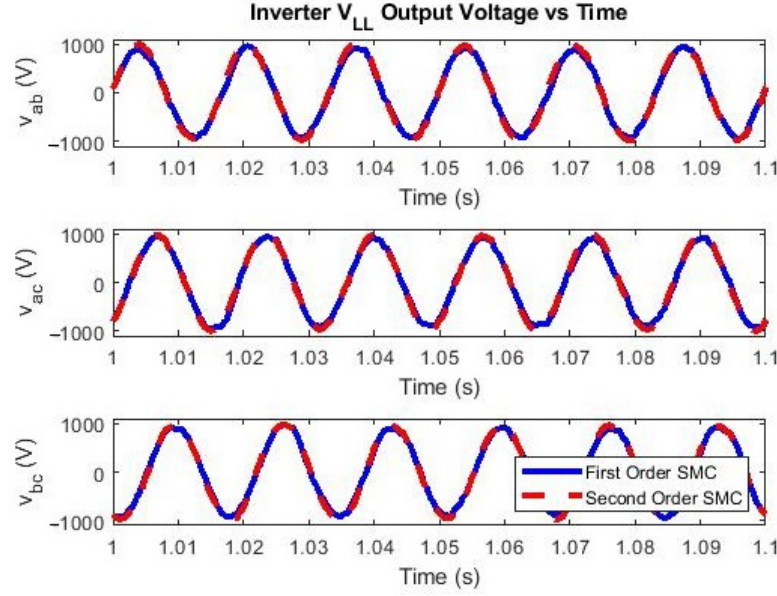
Figure 25. SVPWM inverter V LL output voltage under changing